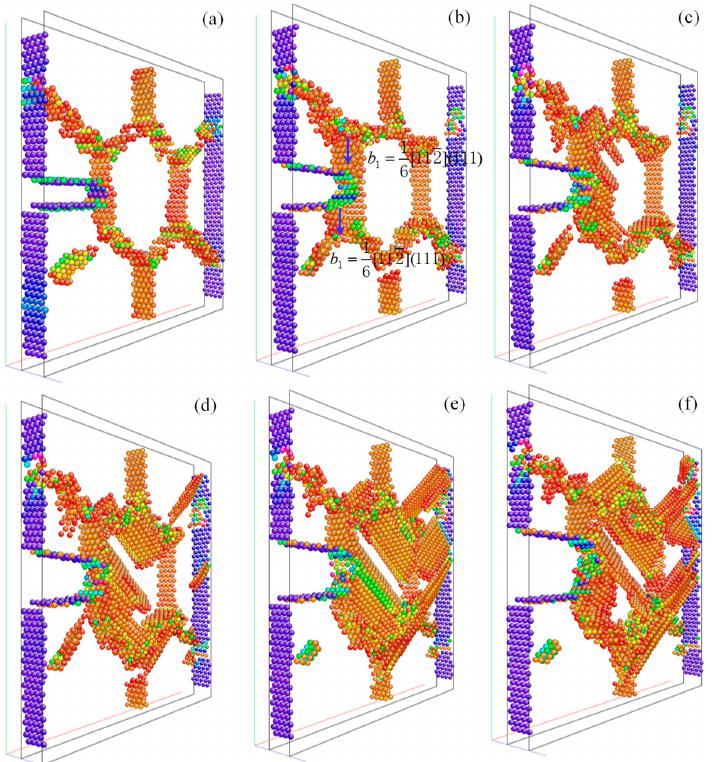
Figure 8. Evolution of atomic configuration in nanoscale polycrystal nickel subjected to early deformation at the strain rate of 2 × 10 10 s − 1 : ( a ) ε = 0; ( b ) ε = 0.06; ( c ) ε = 0.084; ( d ) ε = 0.096; ( e ) ε = 0.12; ( f ) ε = 0.18. (All the configurations are characterized by CSP, where stacking faults are companied by Shockley partial dislocations).